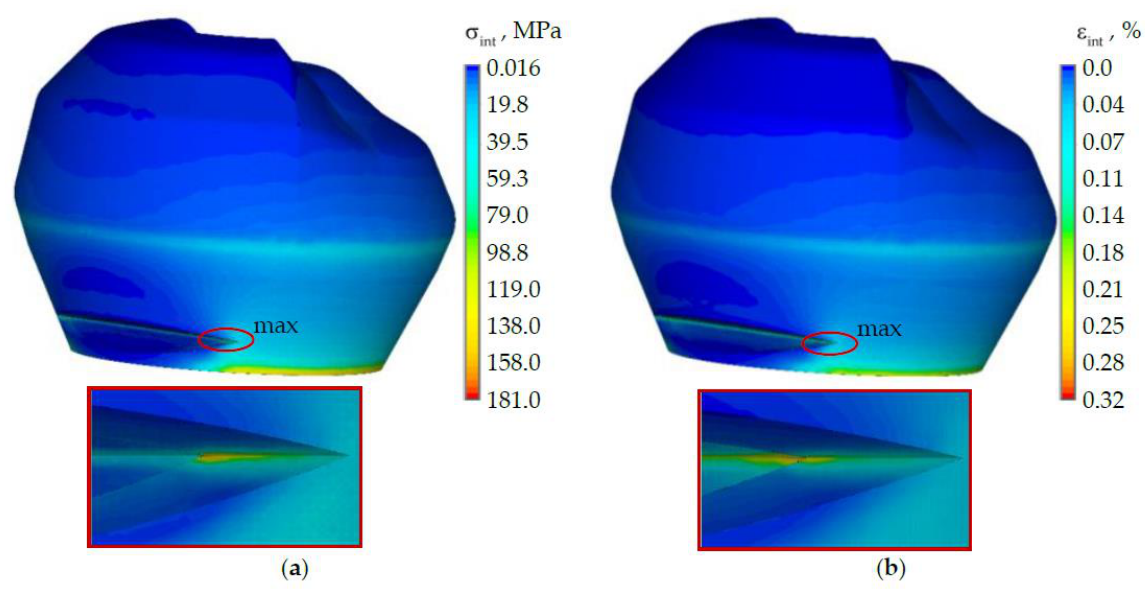
Figure 5. Stress and strain intensity of the tooth with NCCL: ( a ) is stress intensity; ( b ) is strain in- tensity.